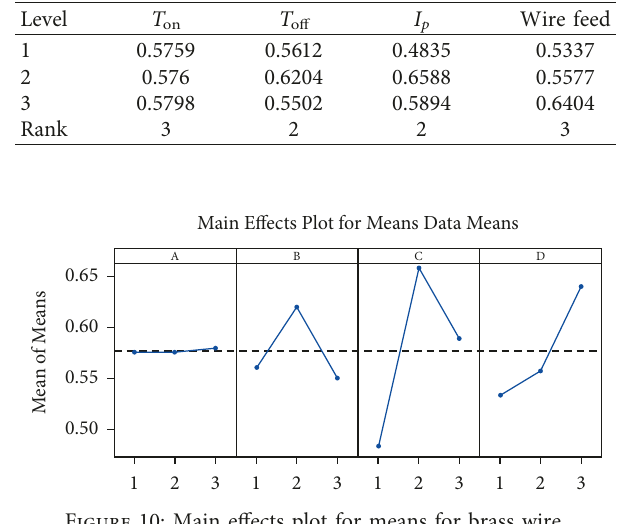
Figure 10: Main effects plot for means for brass